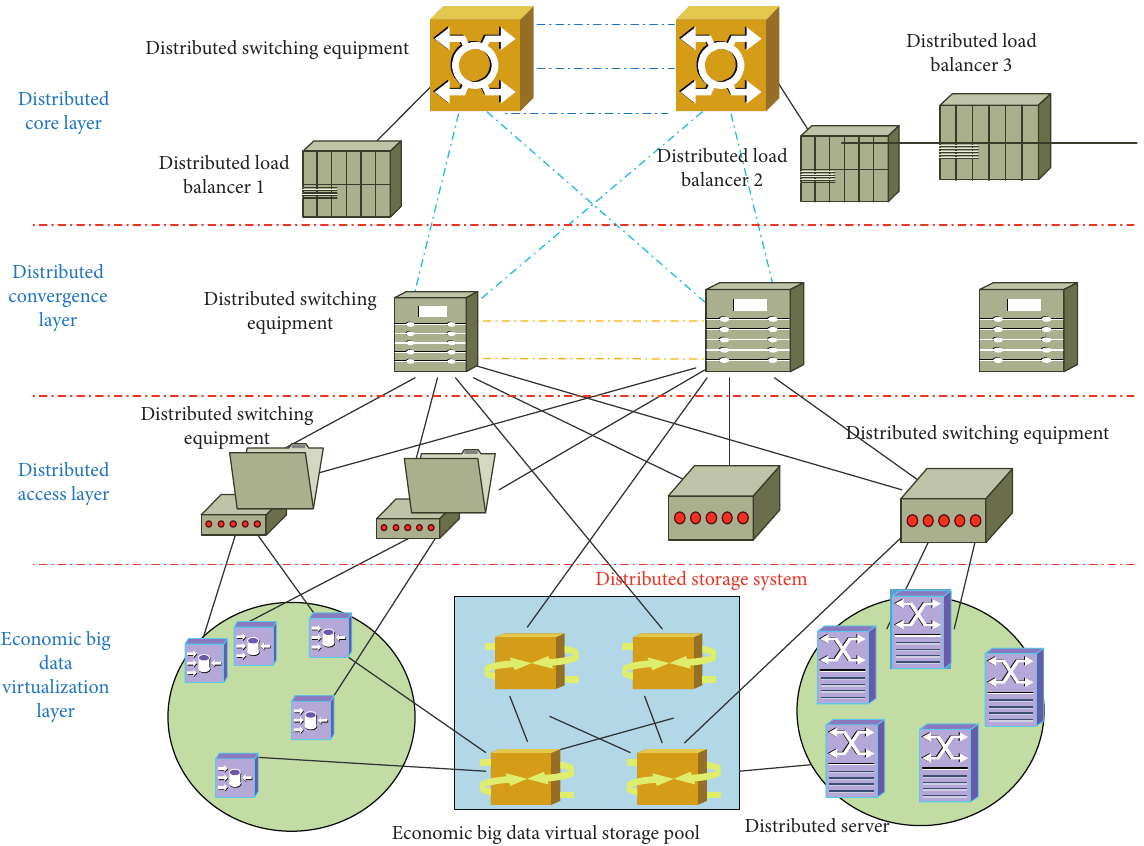
Figure 2: Schematic diagram of distributed computing analysis of economic big